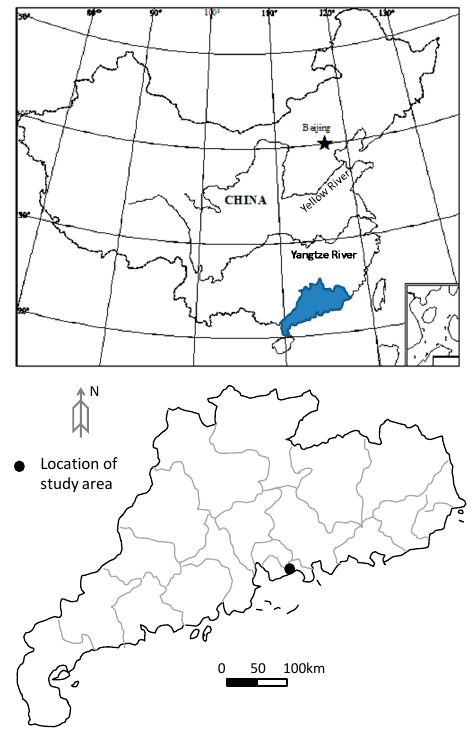
Figure 1. Location of the Shenzhen landfill.